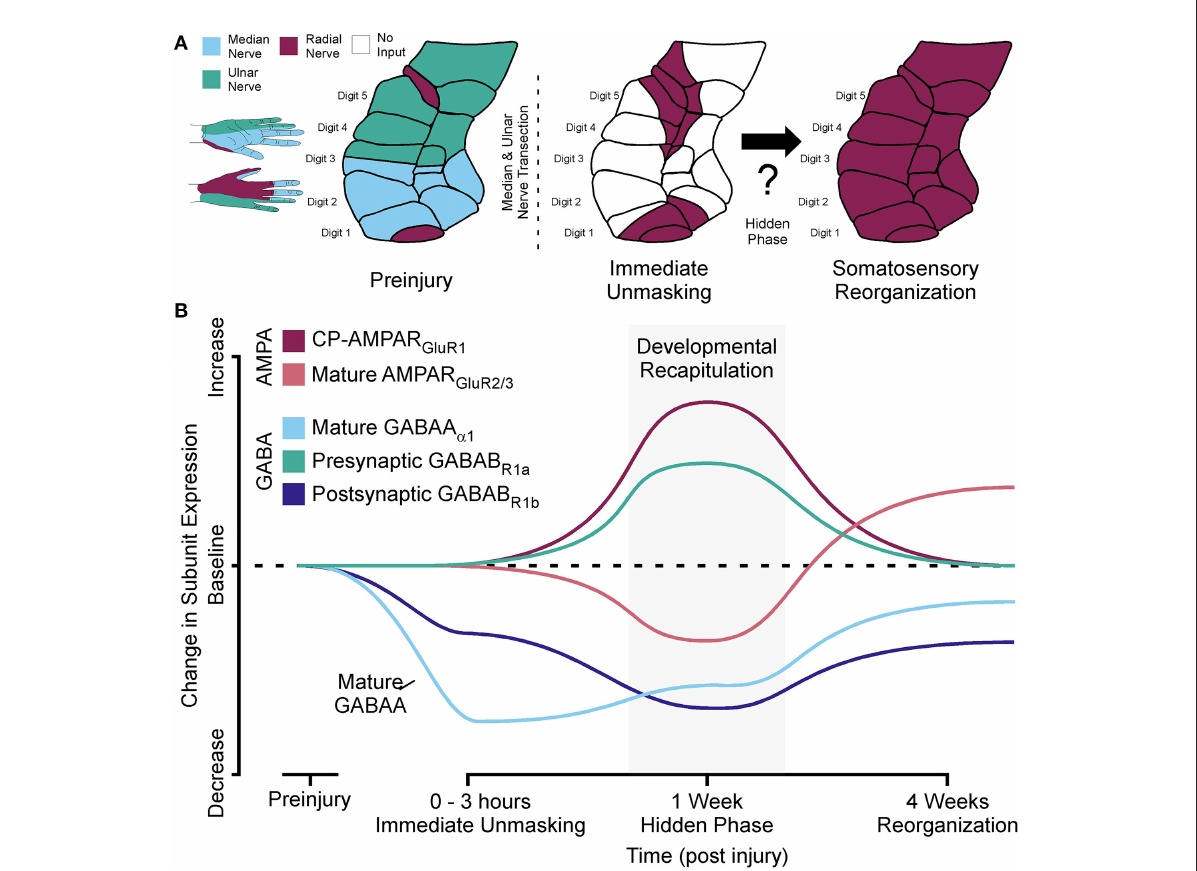
FIGURE1 Developmental recapitulation: a hidden phase of somatosensory reorganization. (A) Left: Cartoon showing the innervation by the median, ulnar, and radial nerve inputs and corresponding receptive fields in area 3b cortex of the non-human primate hand region prior to injury. Right: Cartoon showing how the radial nerve inputs are immediately unmasked prior to complete reorganization of non-human primate area 3b hand representations after median and ulnar nerve transection. (B) Line diagram demonstrating how the shift in AMPA and GABA receptor subunit expressions reveal a previously hidden phase of adult somatosensory reorganization associated with the recapitulation of developmental receptor